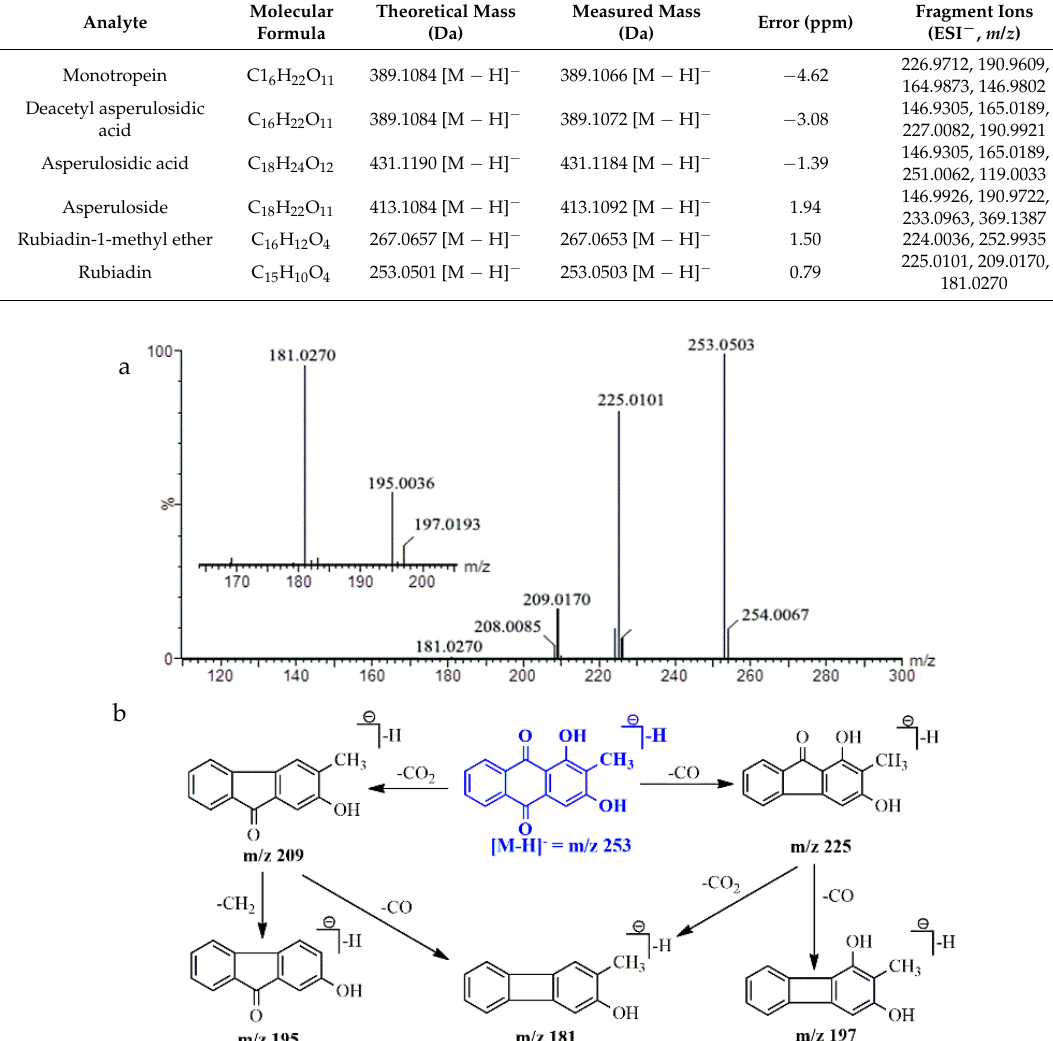
Figure 5. MS/MS spectra ( a ) and the proposed fragmentation pathway ( b ) of rubiadin.